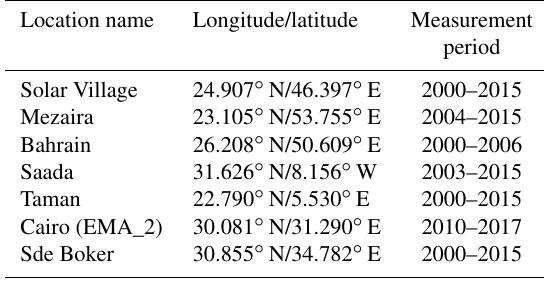
Table 1. Geographic location of the AERONET sites used in this